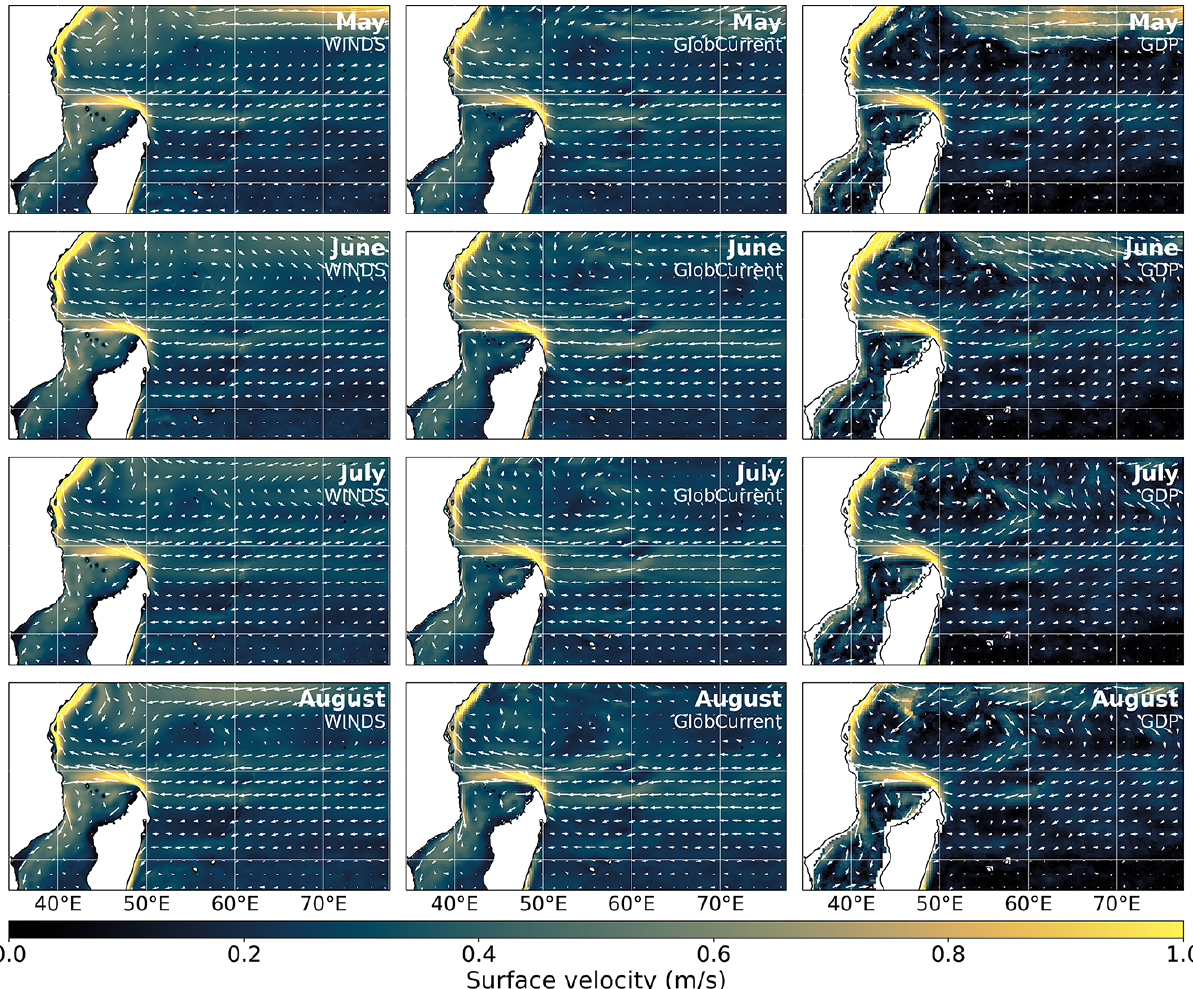
Figure 3. Monthly climatological surface currents (1993–2020) from WINDS (left), Copernicus GlobCurrent Surface (centre), and Global Drifter Program-derived near-surface currents (right) for May to